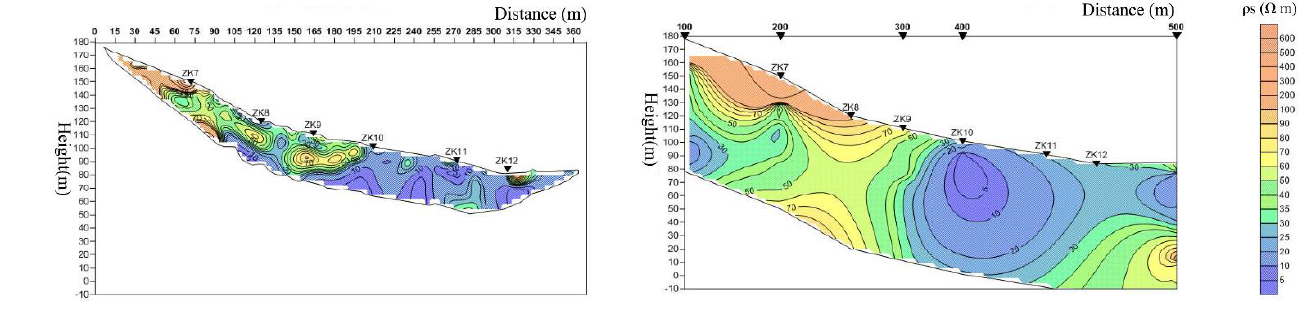
Figure 7. Drilling construction site.